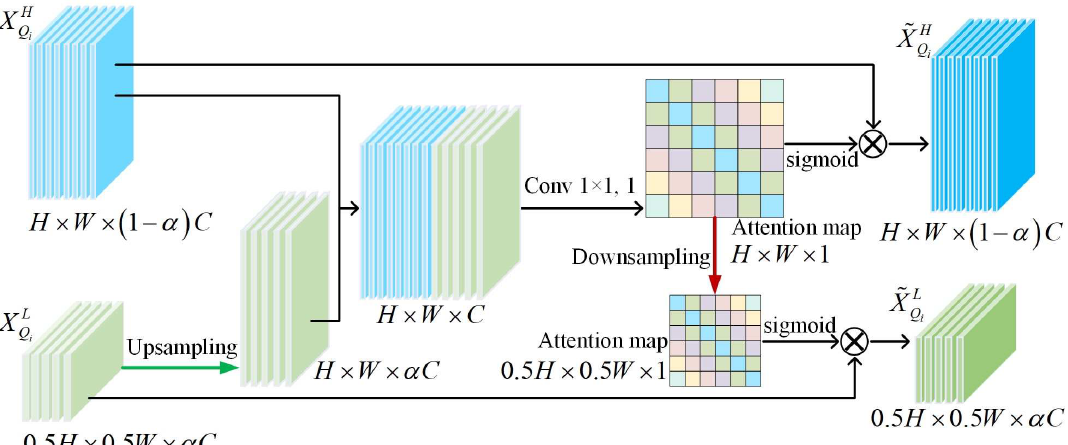
Figure 3. Dual self-attention. The high- and low-frequency components are first used to jointly generate the attention weight map, and then the generated attention weight map are multiplied by the high- and low-frequency components to obtain feature maps after feature enhancement. The feature map size of the low-frequency components is set to half the feature map size of the high-frequency components, so its size is 0.5 H × 0.5 W